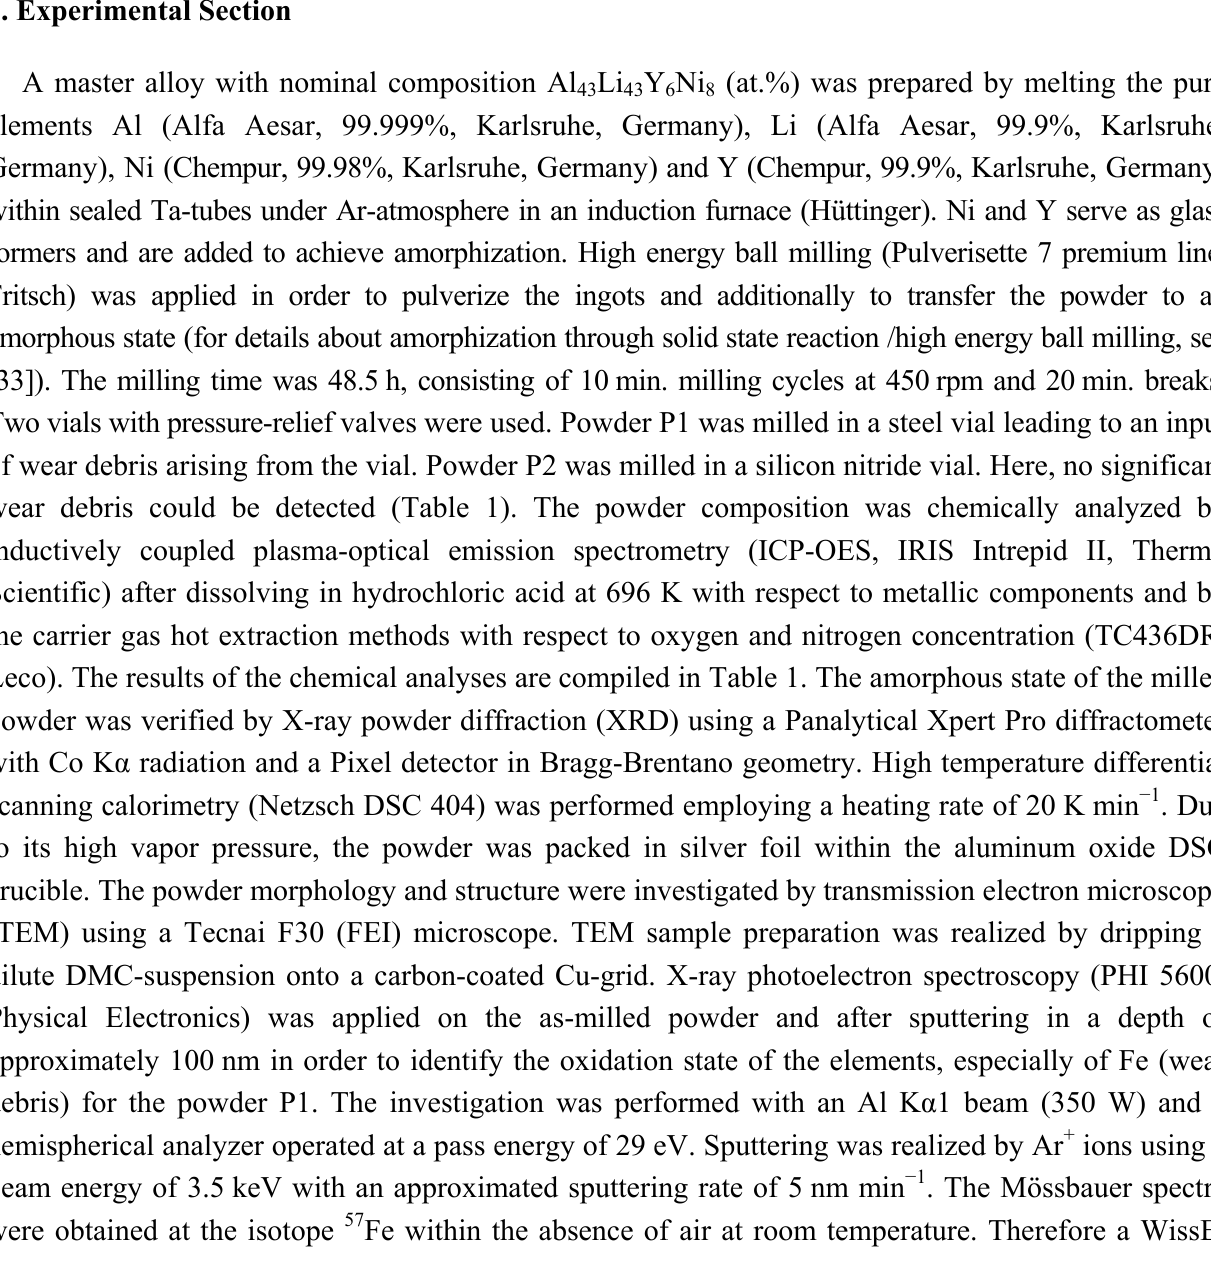
Li Ni Y powders P1 and 43 43 8 6